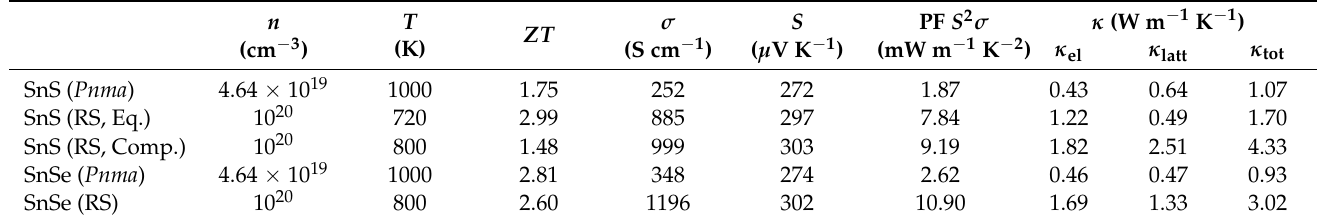
Table 3. Predicted maximum thermoelectric figures of merit ZT for the five systems examined in this work, extracted from Figure 8. For each system, we list the carrier concentration n and temperature T at which the maximum ZT was obtained together with the properties from Equation (1), namely the electrical conductivity σ , the Seebeck coefficient S , the power factor S 2 σ (PF), the electronic and lattice contributions to the thermal conductivity κ el / κ latt , and the total thermal conductivity κ tot